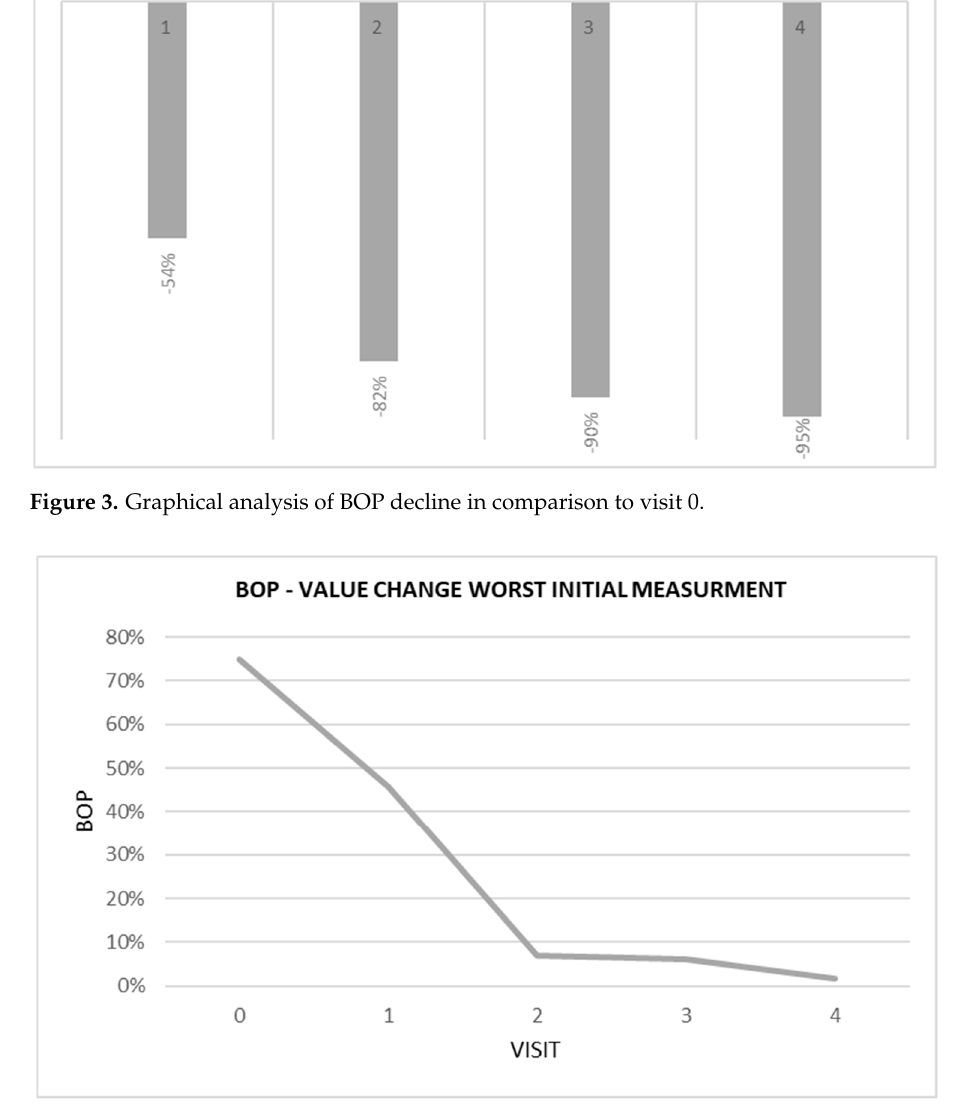
Figure 4. Graphical analysis of BOP changes over time in patient with the worst initial